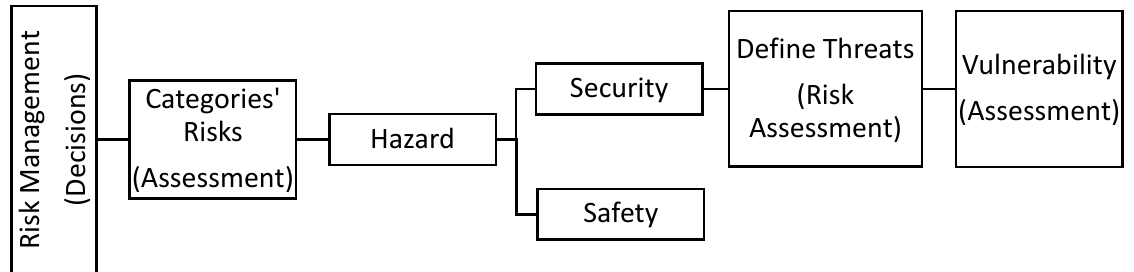
Figure 2. The relationships between risk management and vulnerability assessment.